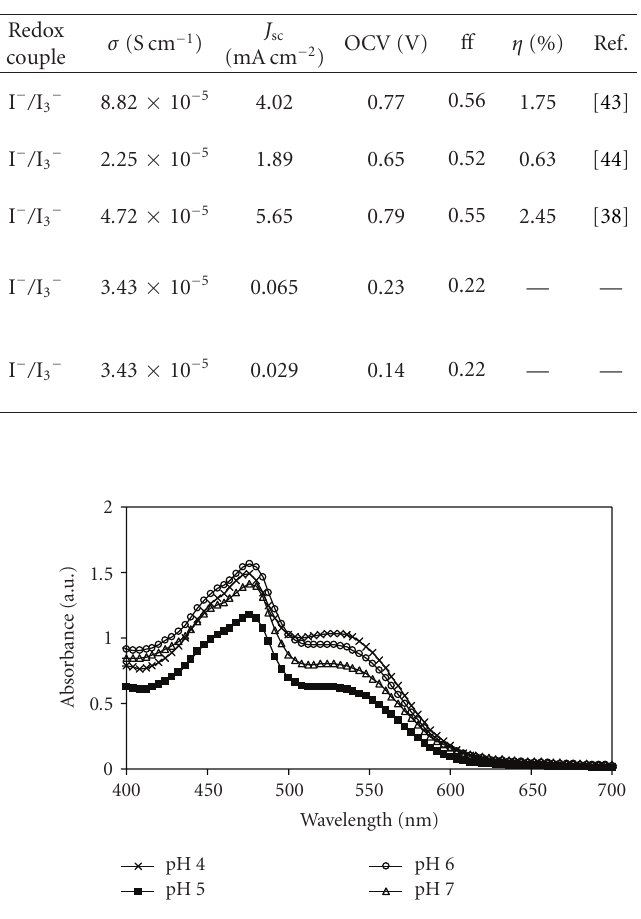
Figure 3: The absorption spectra of betalain at di ff erent pH.